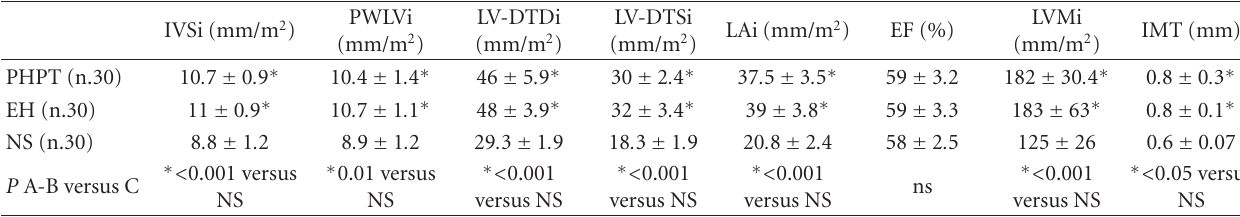
Table 3: Echocardiographic parameters in studied groups.